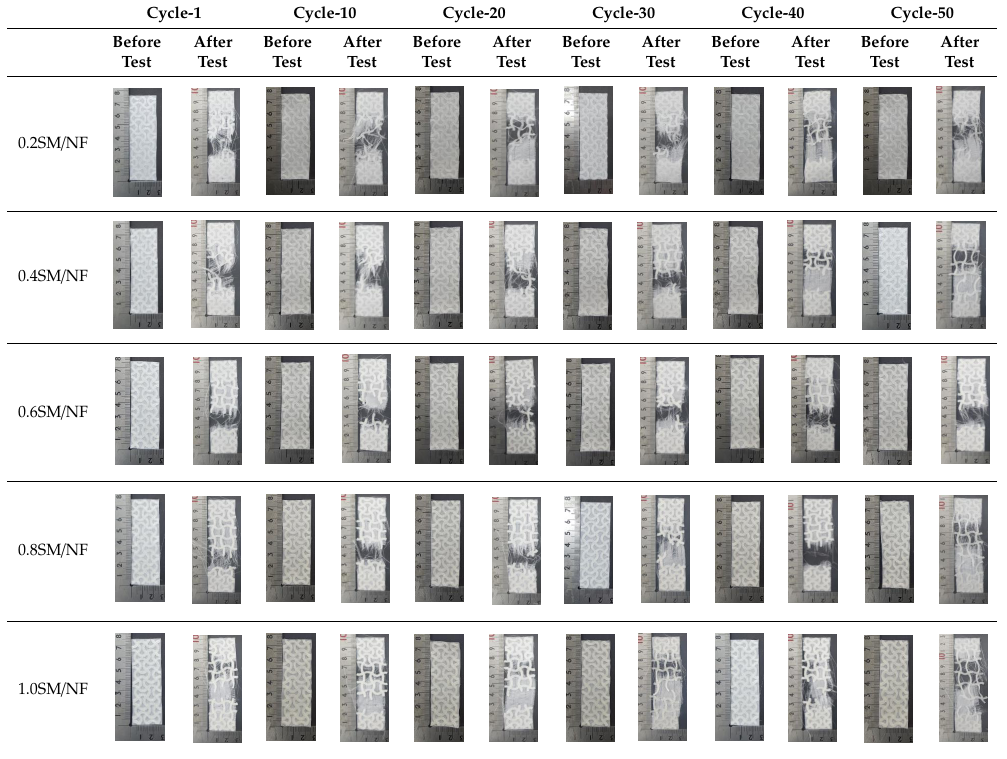
Table 3. Appearance of before and after the tensile tested, 3D-printed sinusoidal sample/nylon composite with various thicknesses and various cycles for 50 cycles.